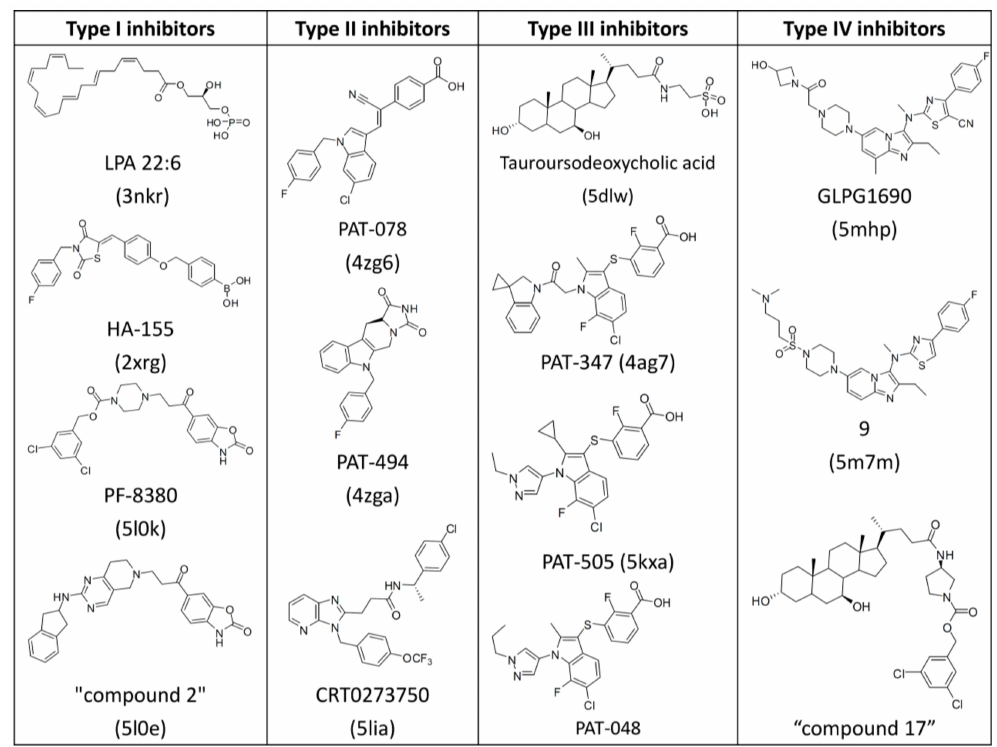
Figure 2. Chemical structures of representative ATX inhibitors. PDB codes of co-crystallized structures with ATX are indicated in